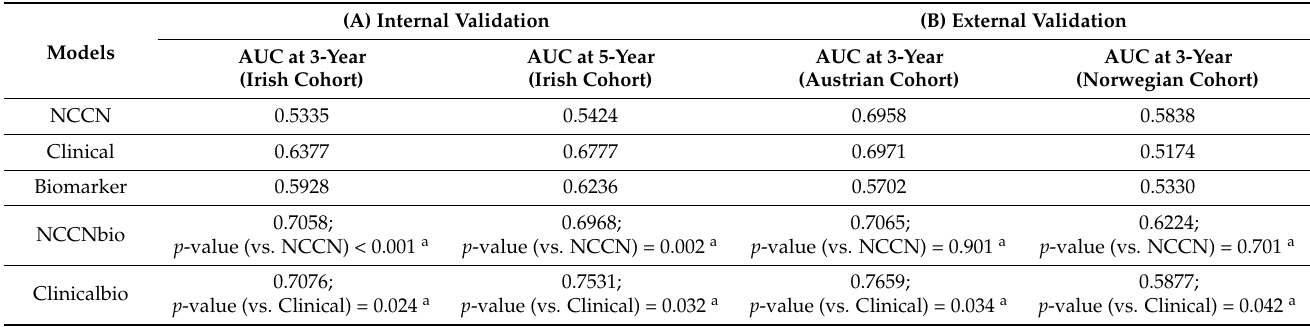
Table 3. The AUC for the ‘NCCNbio’ and ‘Clinicalbio’ compared to ‘NCCN’, ’Clinical’ and ‘Biomarker’ for the internal validation using the Irish cohort (Panel A) and external validation using the Austrian and Norwegian cohorts (Panel B).